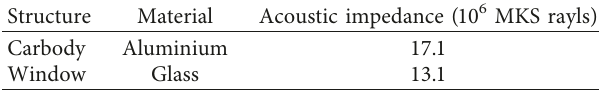
Table 2: Acoustic impedances in the normal direction of the carbody materials (nominal values).